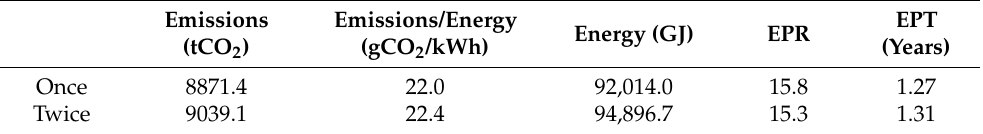
Table 14. CO 2 emissions and energy consumption for the project considering a nacelle replacement. Emissions Emissions/Energy Energy (GJ) EPR (tCO 2 ) (gCO 2 /kWh) Once 9131.3